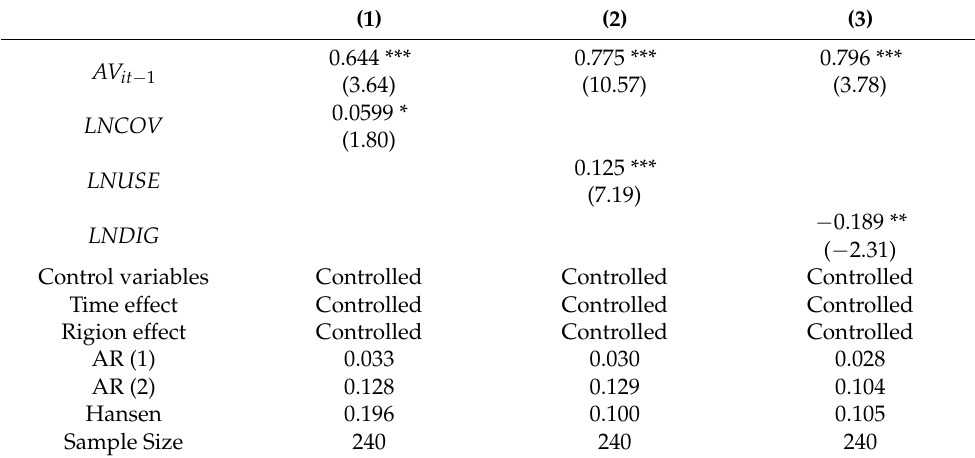
Table 7. The heterogeneous impact of each sub-index of digital financial inclusion on agricultural